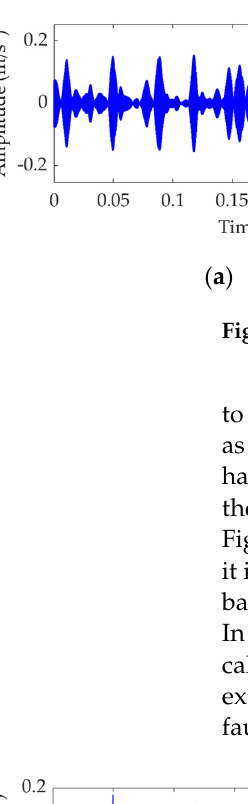
Figure 19. The EP index value of each mode.